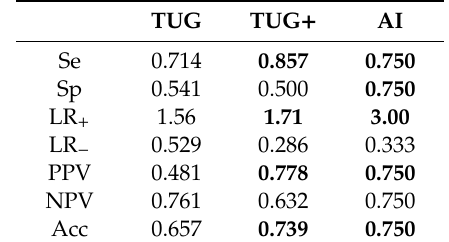
Table 3. Characterization of the TUG and TUG + test. The following parameters are displayed: sensitivity (Se), specificity (Sp), positive (LR + ) and negative (LR − ) likelihood ratios, positive (PPV) and negative (NPV) predictive values and accuracy (Acc). Improvements of TUG + and AI methods with respect to TUG are emphasized in bold font. TUG TUG + AI Se 0.714 0.857 0.750 0.541 0.500